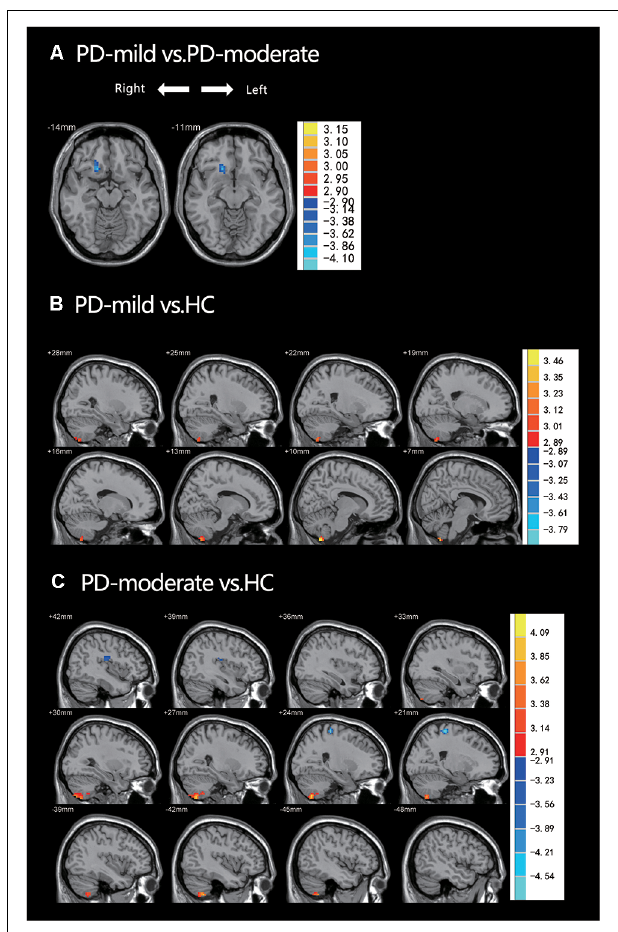
FIGURE 2 | (A) PD-mild vs. PD-moderate groups; ReHo had decreased in the Frontal_Sup_Orb_R and the Rectus_R. (B) PD-mild vs. HC; ReHo had increased in the Cerebellum_8_R. (C) PD-moderate vs. HC; ReHo had increased in the bilateral cerebellum and decreased in the Temporal_Sup_R, Rolandic_Oper_R, Superior Temporal Gyrus, Postcentral_R, and Precentral_R. Table 2 shows more specific information relating to the significant brain